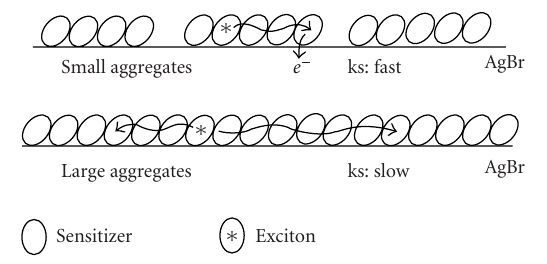
Figure 8: An illustration showing the role of an exciton in its charge separation (i.e., the electron transfer for dye sensitization) in a J - aggregate with variation of size, where k s is the rate constant of the electron transfer.